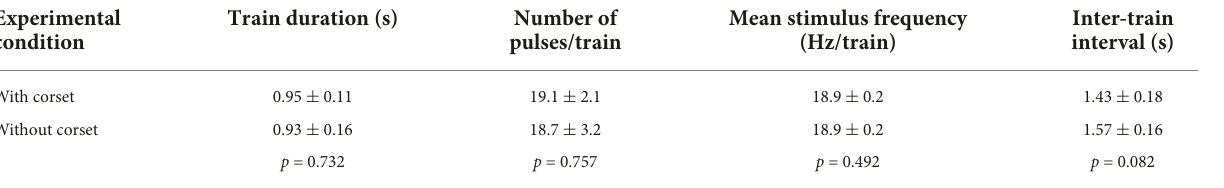
Train duration (s) Number of